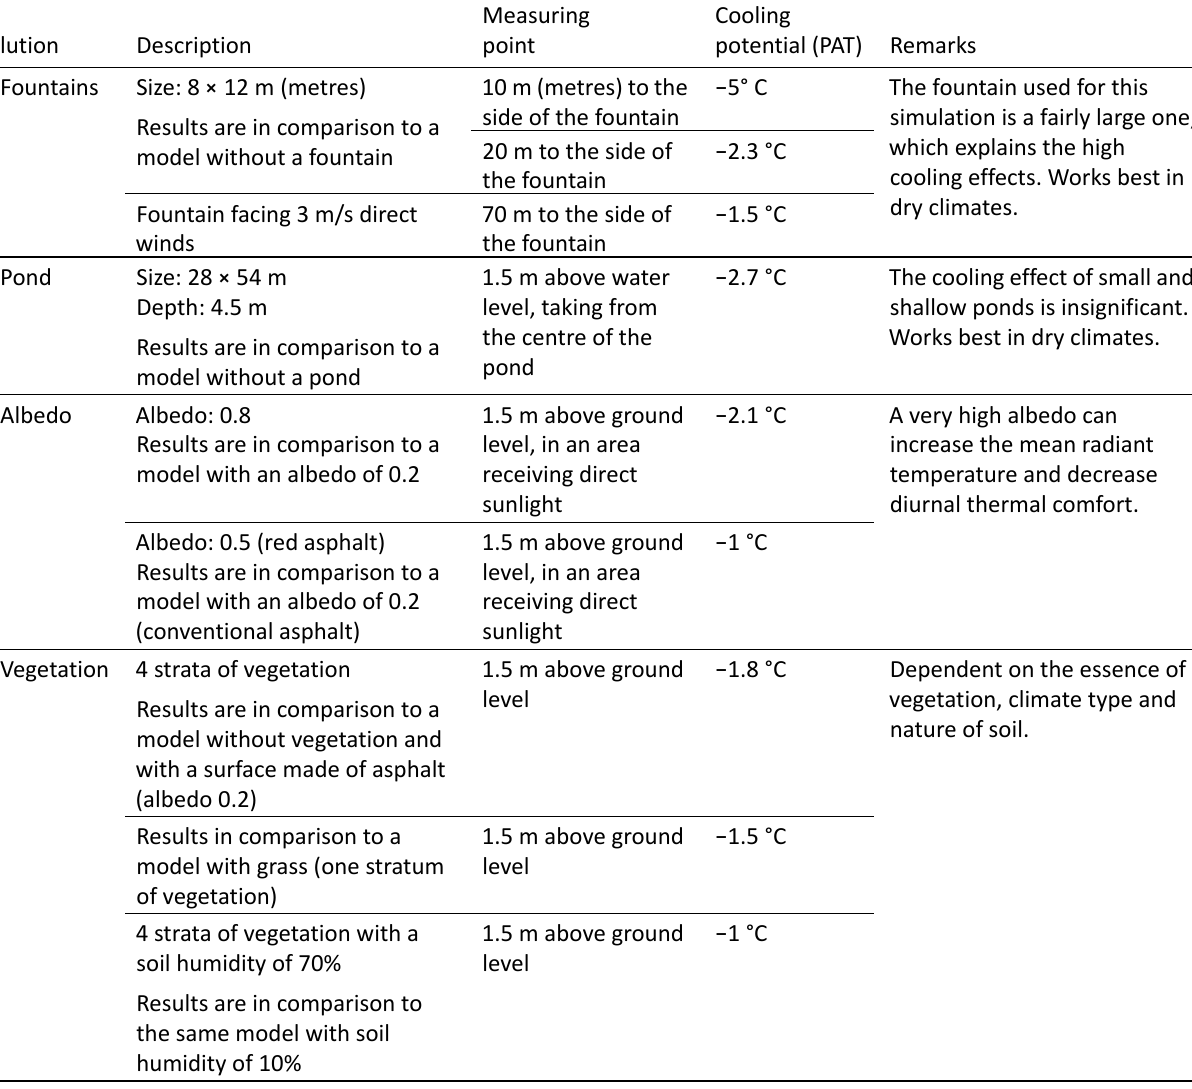
Table 1. Results of the hierarchisation of the cooling effect (PAT) of all simulated solutions on